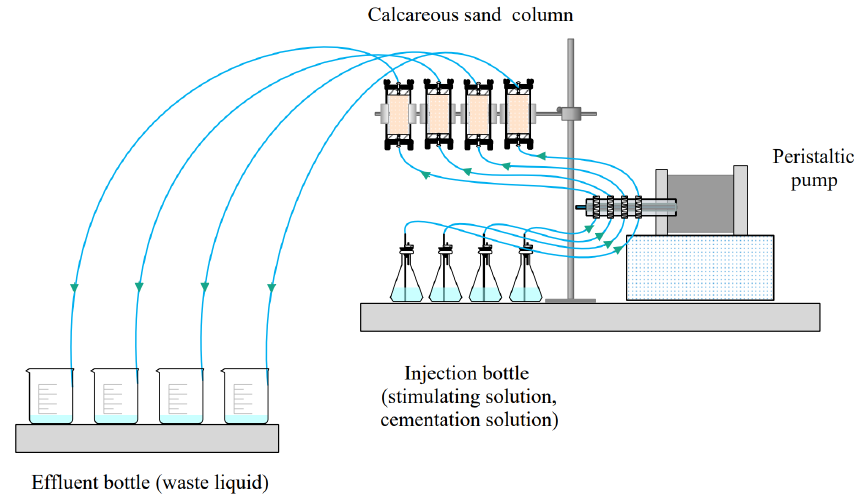
Figure 1. Schematic diagram for the grouting process.